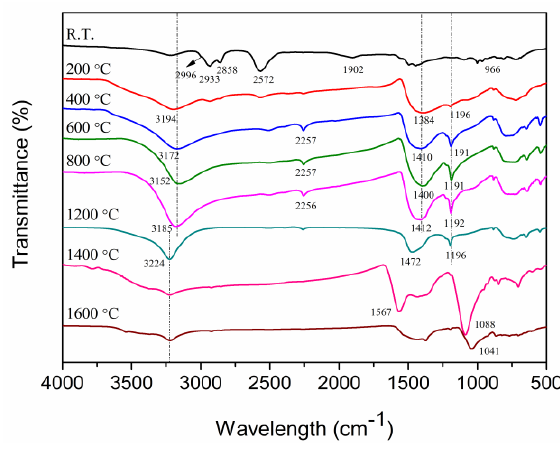
Figure 5. The FT-IR spectra of residues remaining at different pyrolysis temperatures.